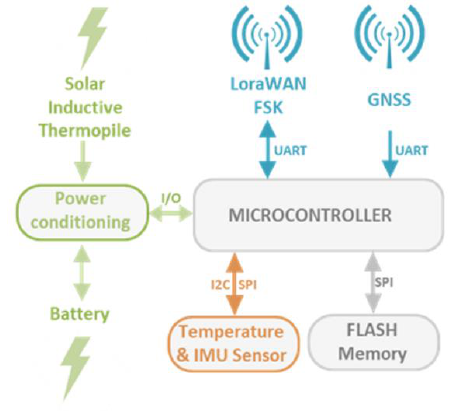
Figure 3. Hardware block diagram.